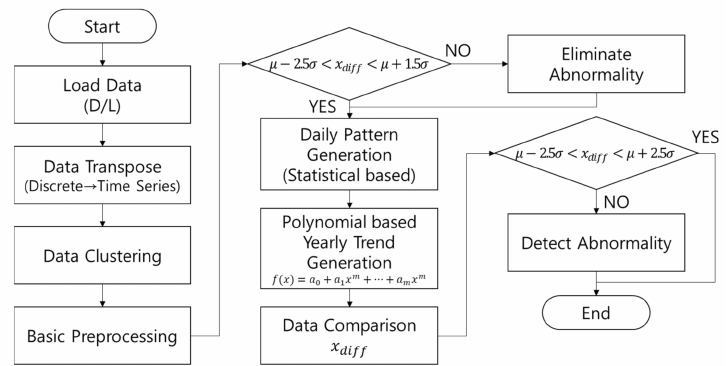
Figure 1. Flowchart of proposed method for abnormal data